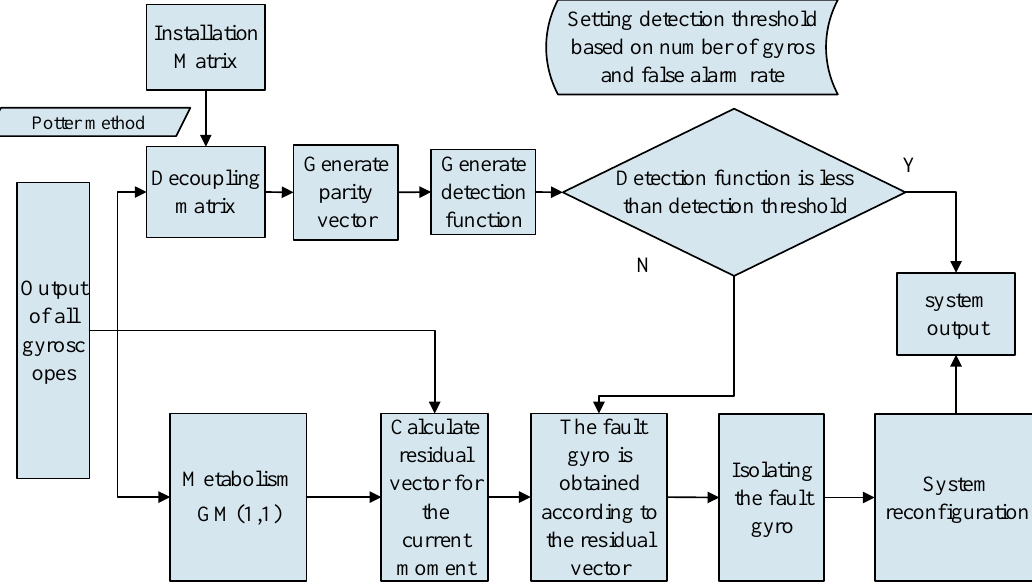
Figure 2. Structure diagram of fault detection and isolation based on the RE-MGM and the generalized likelihood test method.